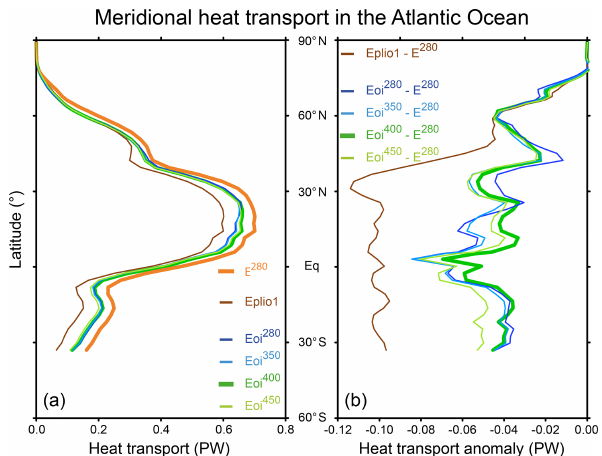
Figure 12. (a) The Atlantic Ocean meridional heat transport in the Pliocene experiments and in E 280 and (b) the anomaly between the Pliocene experiments and E 280 . The core experiment, Eoi 400 , is shown in bold